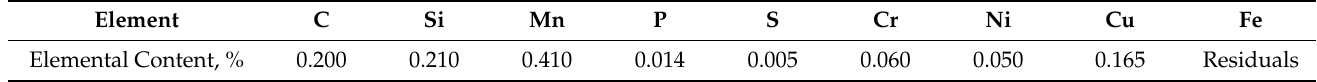
Table 1. Chemical composition of the